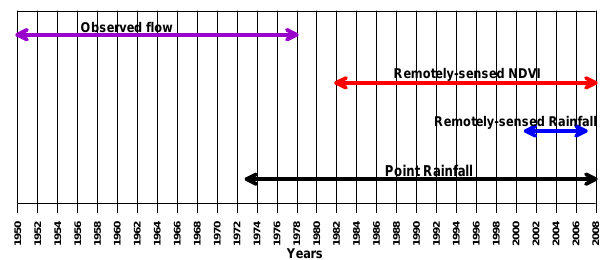
Tree Diagram for 21 Variables